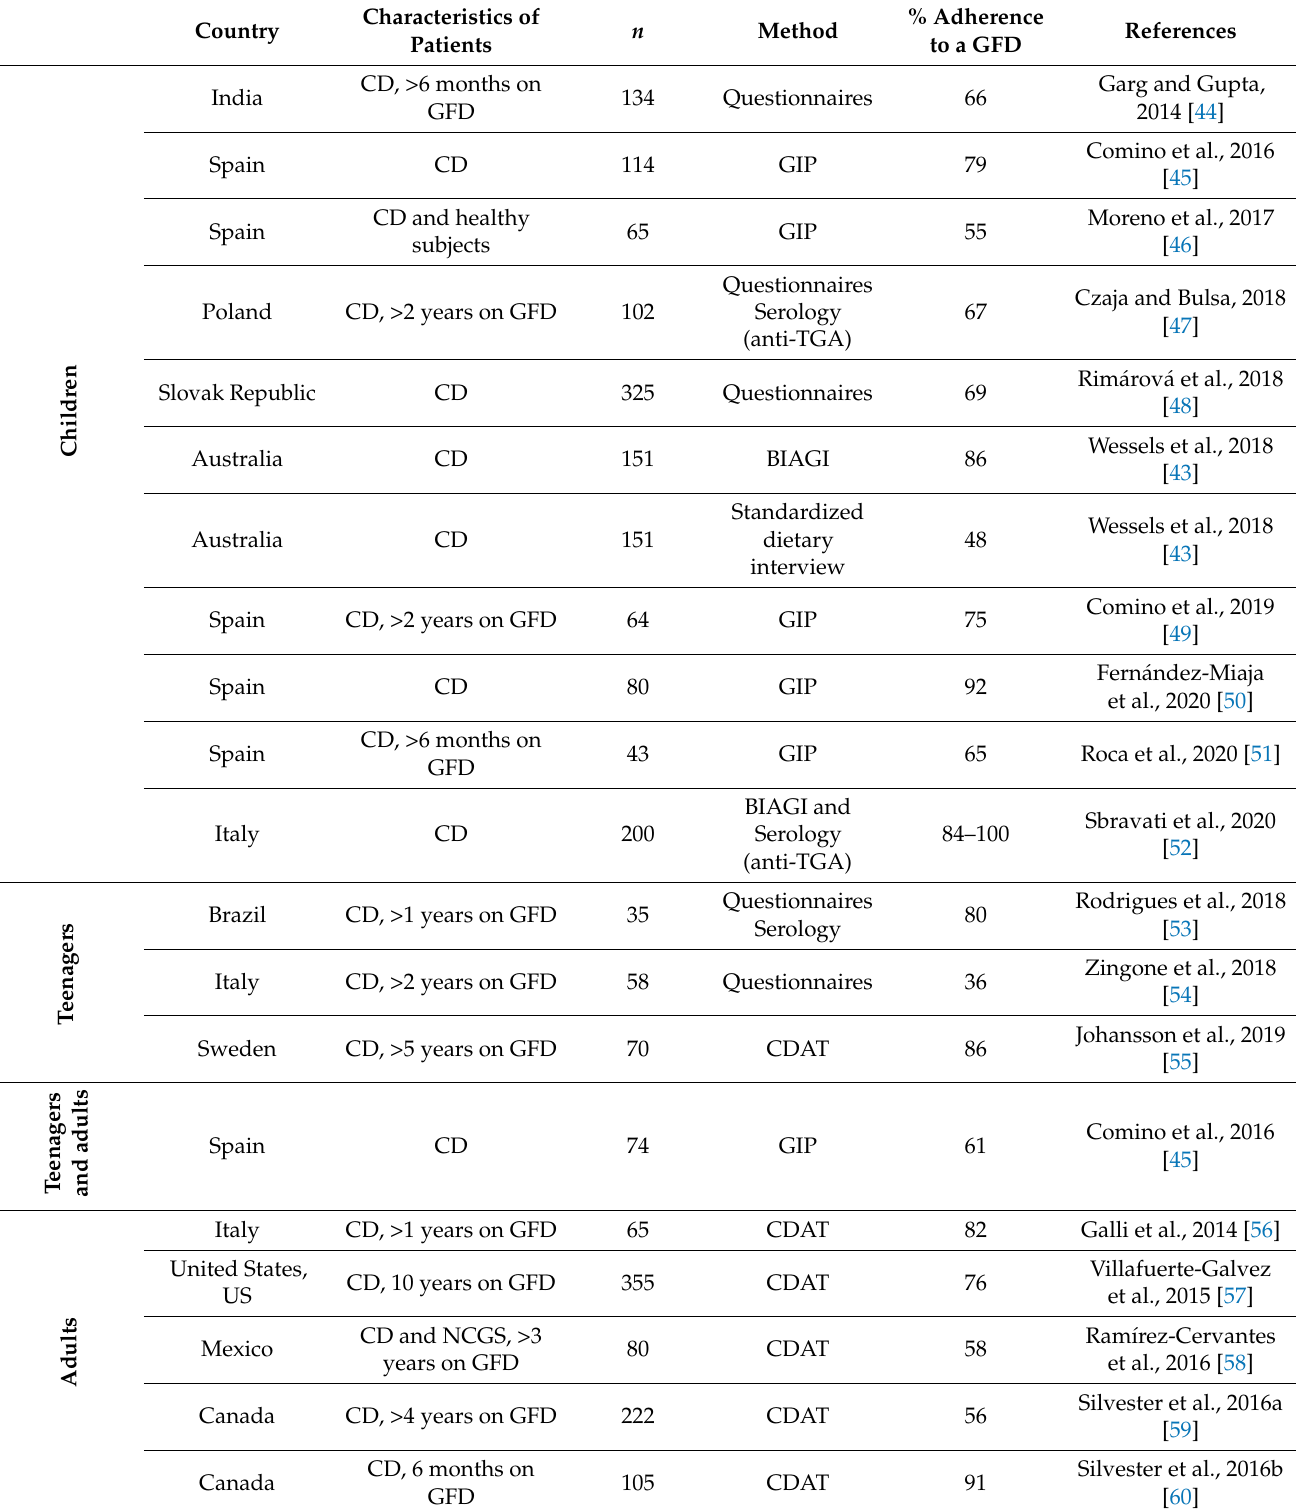
Table 1. Studies on the rate of adherence to GFD in children, adolescents, and adults in different countries. Anti-TGA, anti-tissue transglutaminase antibody; CD, celiac disease; CDAT, Celiac Dietary Adherence Test; GFD, gluten-free diet; GIP, gluten immunogenic peptides; NCGS, non-celiac gluten